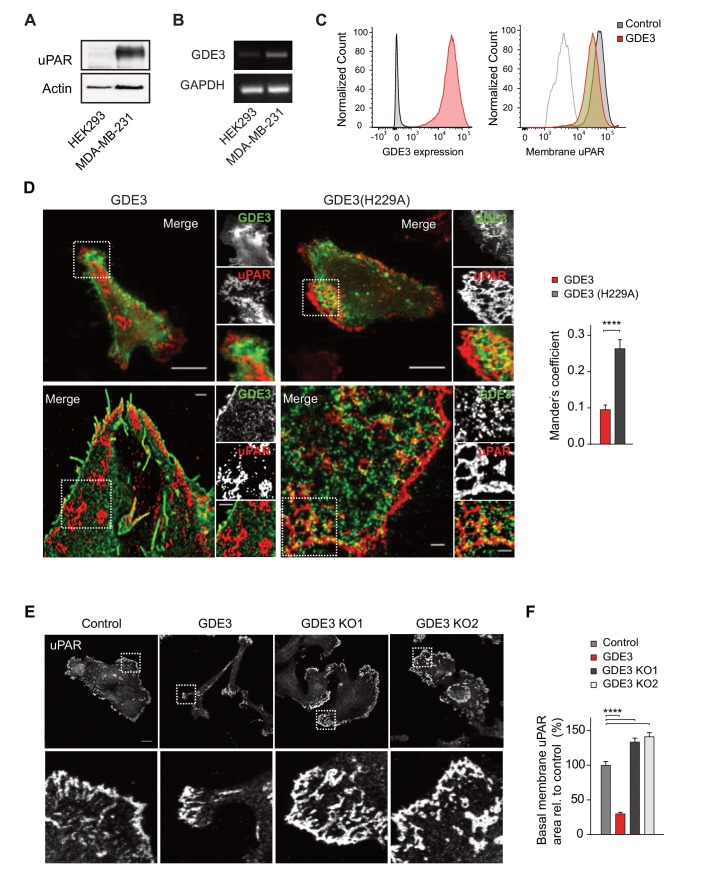
GDE3 depletes uPAR from distinct basolateral membrane domains in MDA-MB-231 breast cancer cells.(A) Endogenous uPAR expression in MDA-MB-231 versus HEK293 cells, as determined by immunoblot. (B) Endogenous GDPD2 expression, as determined by qPCR analysis. (C) (left) Cell-surface expression of GDE3-mCherry of MDA-MB-231 cells expressing GDE3, as detected by flow cytometry. (Right) Cell-surface expression of uPAR in control (grey) and GDE3-expressing MDA-MB-231 cells (red), as detected by flow cytometry. (D) Confocal (top) and dual-color super-resolution microscopy images (bottom) of MDA-MB-231 cells expressing GDE3-GFP or catalytically dead GDE3(H229A)-GFP. Endogenous uPAR was immunostained in red. Merged images show colocalization of uPAR with GDE3(H229A) but not with wild-type GDE3 and uPAR. Scale bars, 10 μm (confocal) and 1 μm (super-resolution). Co-localization analysis (Mander's coefficient) on peripheral uPAR patches in confocal images was done using ImageJ software (n = 30 cells, three independent experiments). (E) Endogenous uPAR staining in control, GDE3-overexpressing and GDE3 knockout MDA-MB-231 cells plated on vitronectin. Two distinct GDE3 knockout clones (KO1 and KO2) were examined, as indicated. Scale bar,10 μm. (F) Quantification of basolateral uPAR-containing membrane domains referring to the cells in panel (E) (n = 3, mean ±SEM, ****p<0.0001). GDE3 suppresses the vitronectin- and uPAR-dependent phenotype of MDA-MB-231 breast cancer cells.